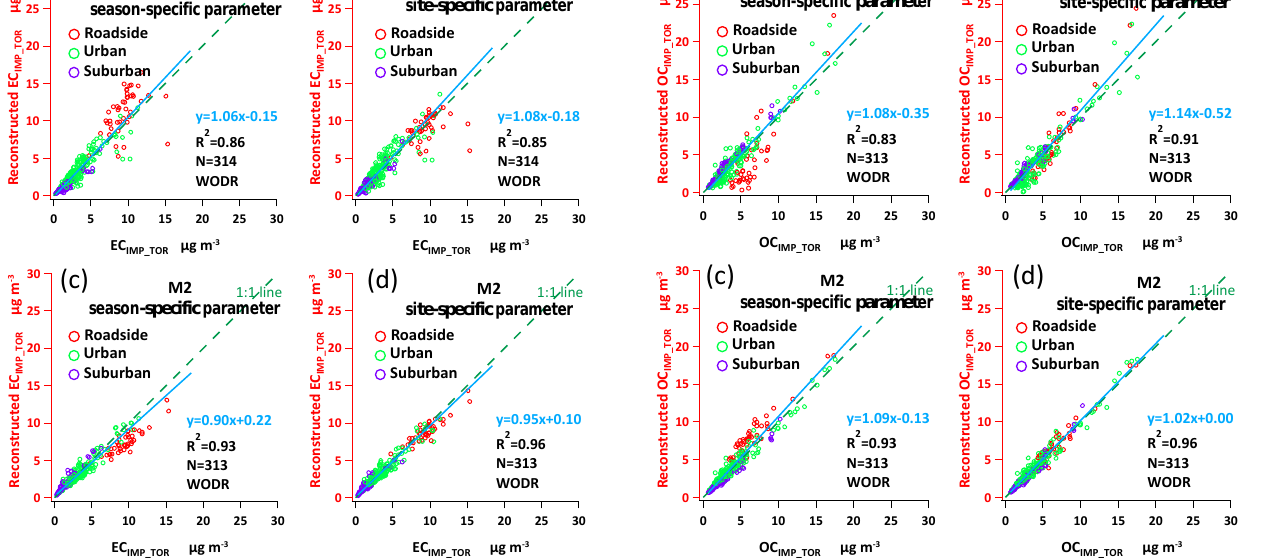
Figure 8. Reconstruction of OC IMP_TOR calculated using Eq. (7). (a) Reconstruction by season-specific parameters using M1. (b) Re- construction by site-specific parameters using M1. (c) Reconstruc- tion by season-specific parameters using M2. (d) Reconstruction by site-specific parameters using M2.